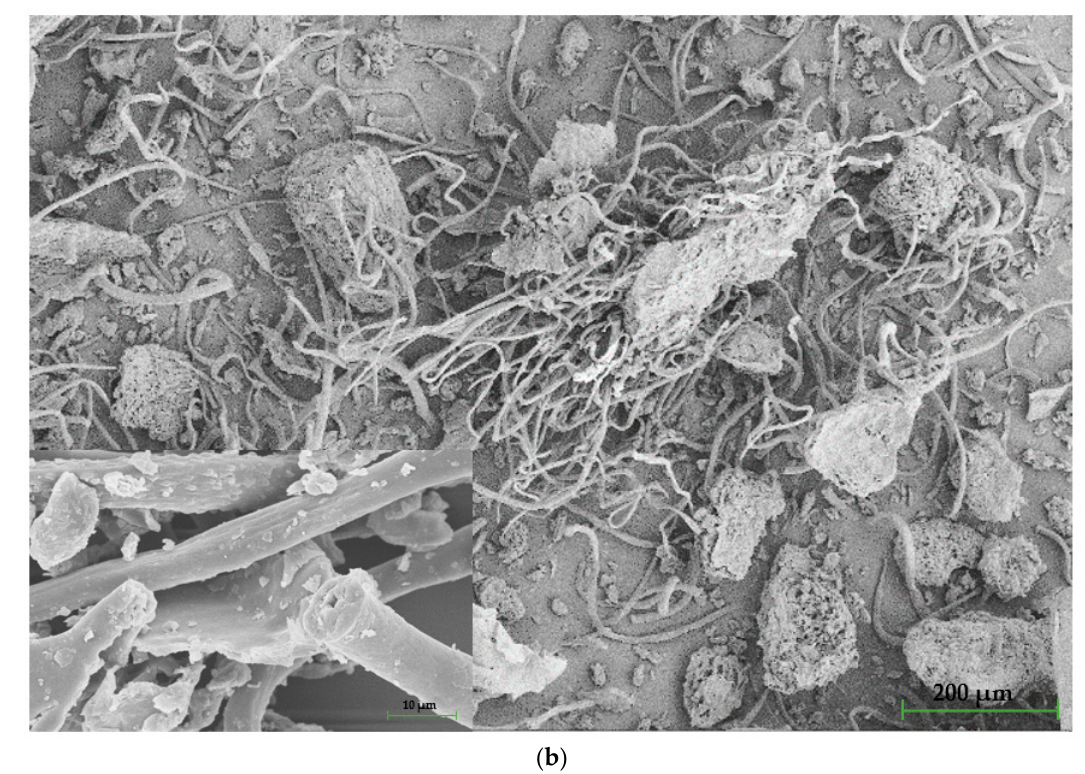
Figure 5. SEM micrographs of thyme—( a ) and sage—( b ).